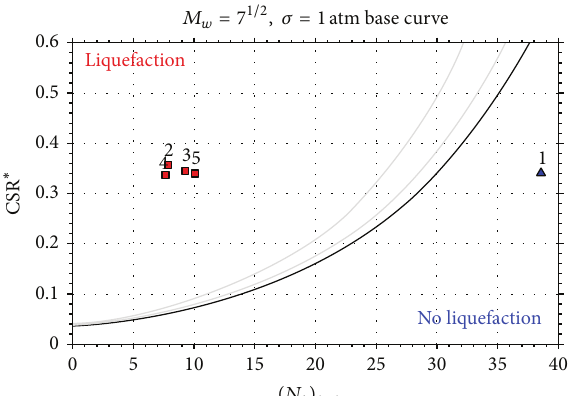
Figure 11: Borehole 23 was chosen to check and compare for liquefaction potential as scattering liquefaction points of sample for SPT- 𝑁